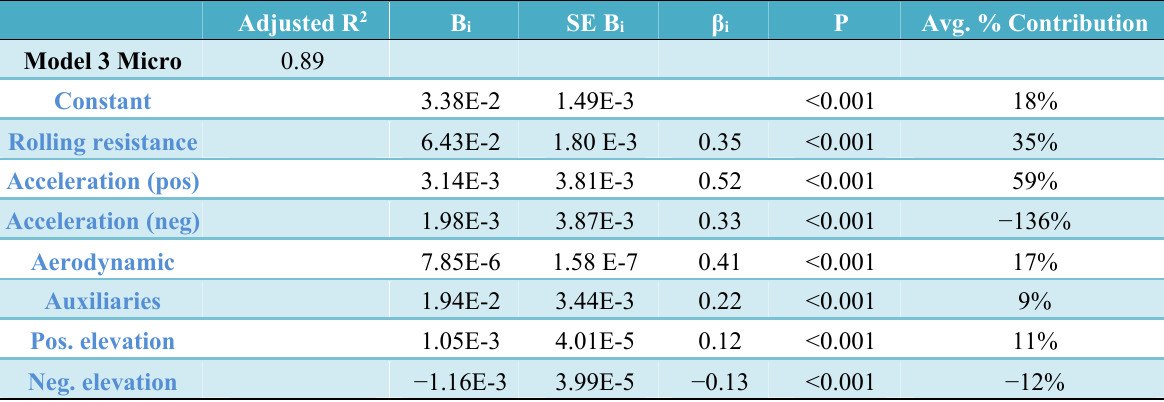
Table 2. Results of the multiple linear regression for the micro-trip